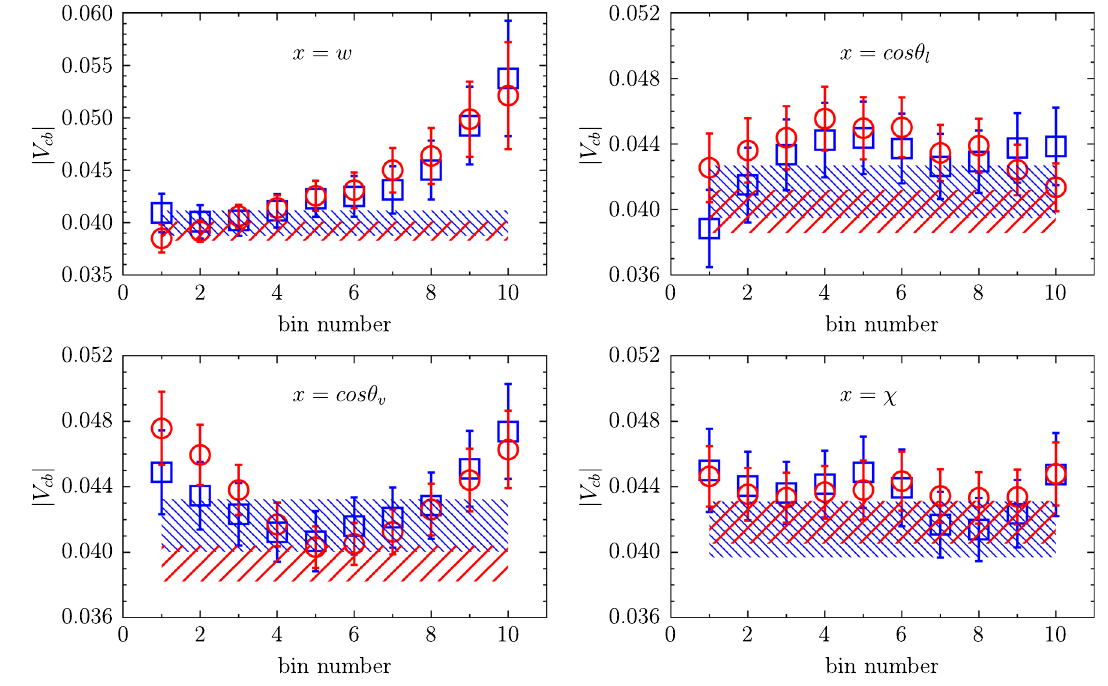
Fig. 2 The bin-per-bin estimates of | V cb | and their weighted means (4)–(5) for each kinematical variable x and for each experiment adopt- ing the original covariance matrices of the Belle experiments. The blue squares and the red circles correspond respectively to the first [15] and